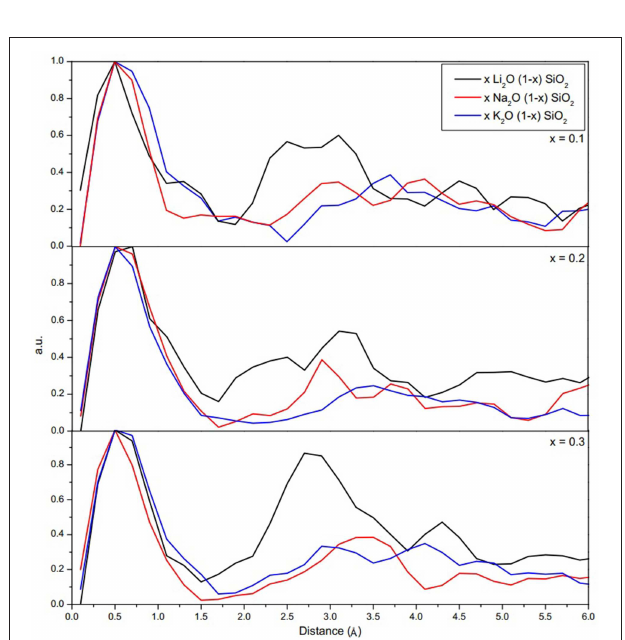
FIGURE 2 | Probability density function of the jump distance for the alkali ions. The jump distances can be estimated from the difference between two points in which the ions spent more time during the